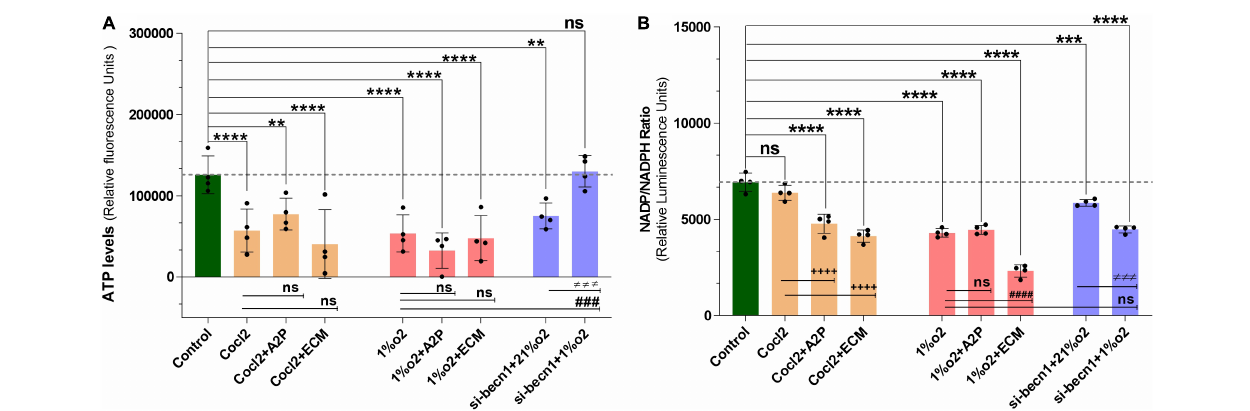
FIGURE 5 | Hypoxia and Beclin1 inhibition decrease the H9c2 cells ATP levels and NADP/NADPH ratios. (A) The graph indicate the relative luminescence changes of ATP levels and (B) NADP/NADPH ratios in H9c2 cells exposed to CoCl2, Hypoxia (1%O2), Normoxia conditions (21%O2) and treated with ECM, A2P, siRNA-Beclin1. Compared to controls, ATP levels decreased in Cocl2 (**** p < 0.0001), Cocl2 + A2P (*** p < 0.009), Cocl2 + ECM (**** p < 0.0001) and in hypoxia (1%o2) exposed cells (**** p < 0.0001), 1%o2 + A2P (**** p < 0.0001), 1%o2 + ECM (**** p < 0.0001). In Beclin-1 inhibition cells, ATP levels are decreased under normoxia (21%o2) condition (*** p < 0.0006), and no significant change was observed in Beclin-1-inhibition cells exposed to Hypoxia. However, compared to Hypoxia cells ATP levels, Beclin-1 inhibition cells grown under Hypoxia showed increased ATP levels ( ### p < 0.001). In H9c2 cells, compared to controls NADP/NADPH levels was decreased in Cocl2 + A2P (**** p < 0.0001), Cocl2 + ECM (**** p < 0.0001), hypoxia (1%O2) **** p < 0.0001, 1%O2 + A2P (**** p < 0.0001) and in 1%O2 + ECM (**** p < 0.0001) exposed cells. In beclin-1 inhibition cells, NADP/NADPH levels were decreased under normoxia (21%O2) condition (*** p < 0.0008) and in Hypoxia exposure (**** p < 0.0001). In addition, compared to Cocl2 exposed cells Cocl2 + A2P ( ++++ p < 0.0001), Cocl2 + ECM ( ++++ p < 0.0001) cells NADP/NADPH-ratio was further decreased and same way compared to Hypoxia, 1%O2 + ECM ( #### p < 0.0001) cells NADP/NADPH levels also decreased significantly. Data represents, n = 4 independent samples/group; Bars are mean ± S.D. Symbols *, +, #, and (cid:54)= denotes significant, “ns” represents not significant by two-way ANOVA- multiple comparisons test. P-values are ns p > 0.05, * p < 0.05, ** p < 0.01, *** p < 0.001 and **** p < 0.0001 compared to Control; + p < 0.05, ++ p < 0.01, +++ p < 0.001 and ++++ p < 0.0001 compared to Cocl2; # p < 0.05, ## p < 0.01, ### p < 0.001 and #### p < 0.0001 compared to